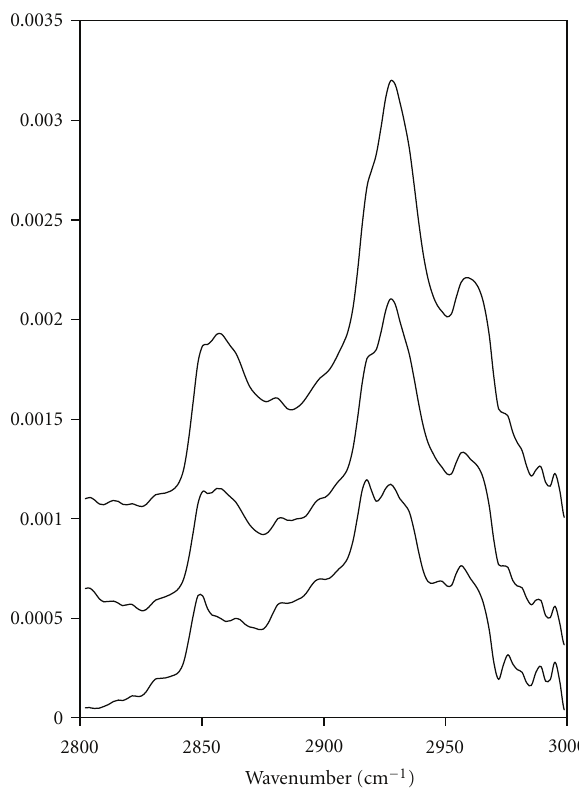
Figure 5: FTIR spectra of chemisorbed OCTS prior to exposure to UV light (upper trace) and following 5min (middle trace) and 15min (lower trace) of exposure under a positive bias of 800mV. The traces were vertically shifted for clarity.